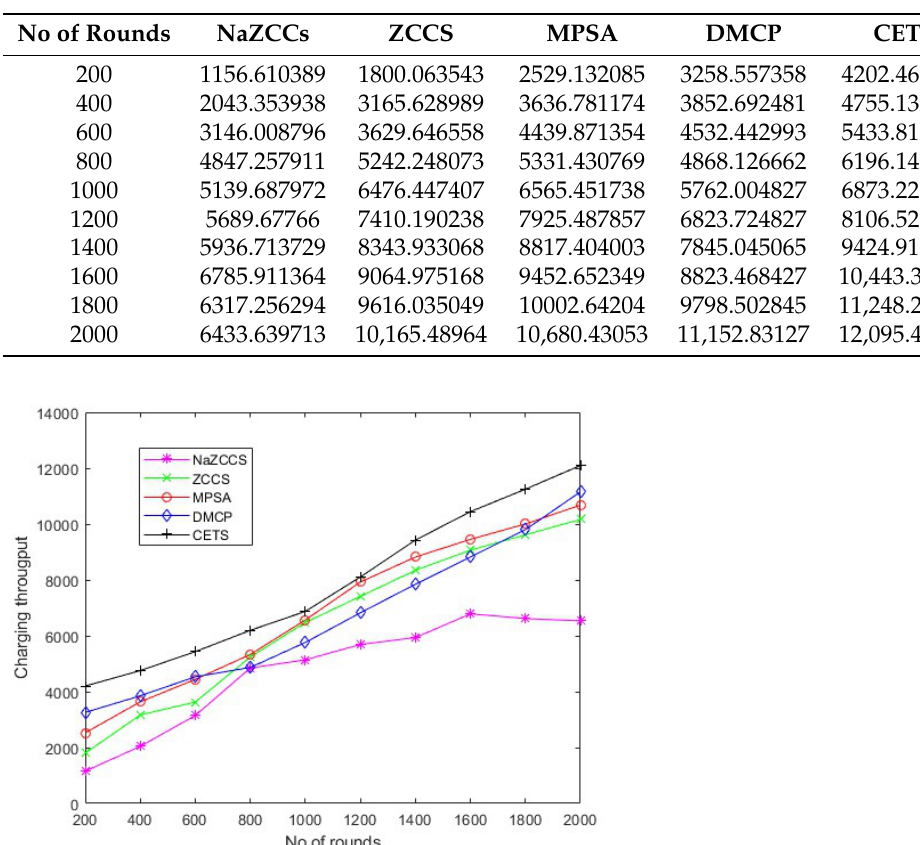
Figure 12. CETS versus other models on charging throughput per round at hop density 0.1. Table 9. CETS versus other models on charging throughput per round at hop density 0.2.